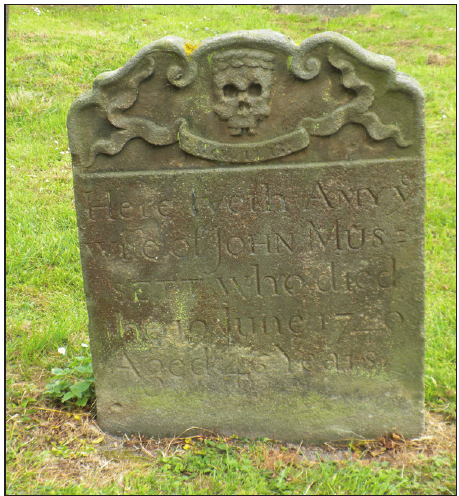
Figure 2: Skull wearing a laurel wreath:Death the victor. St Margaret’s Church, Cley-next- the-Sea, Norfolk (Photo Author).